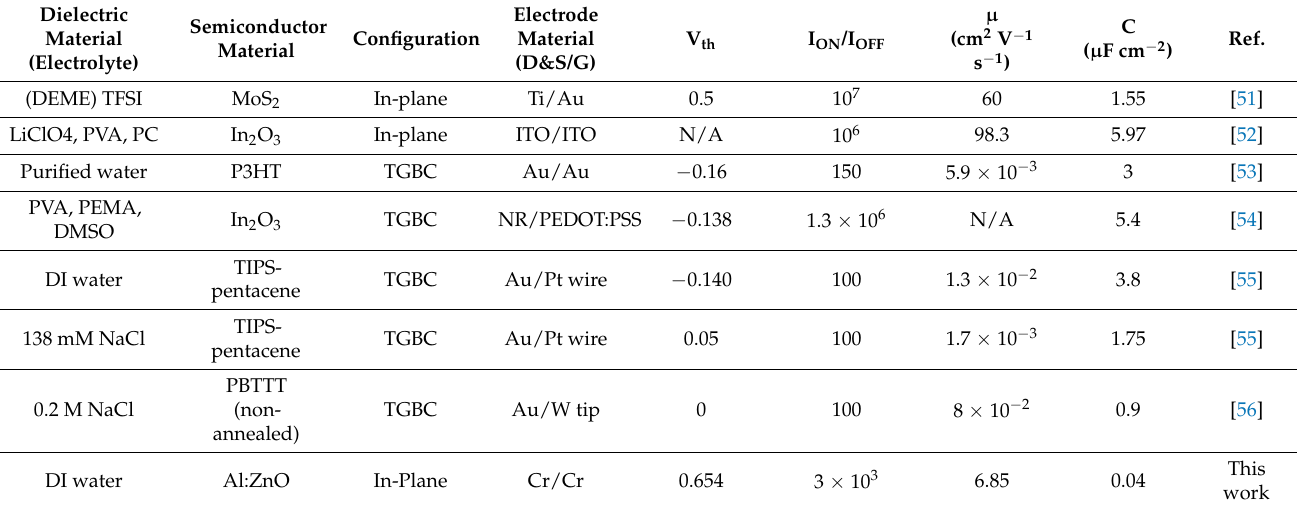
Table 1. A summary of the properties of the various types of